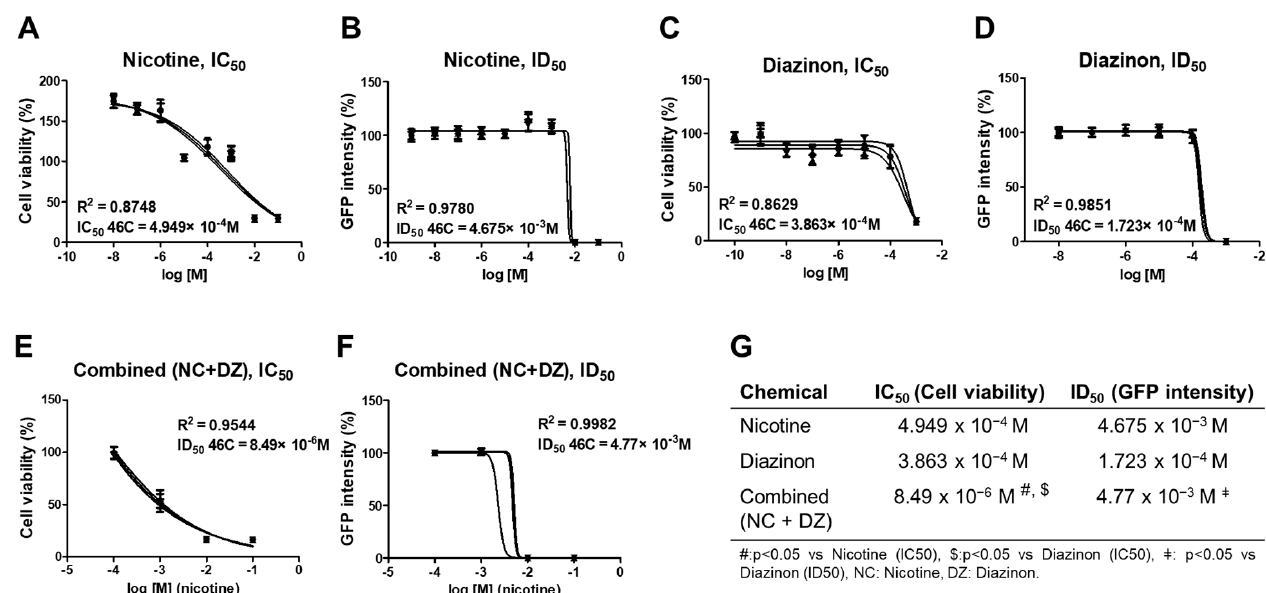
Figure 1. Synergistic adverse effect of combined exposure to nicotine and diazinon in vitro. ( A – F ), Sox1-GFP cell viability assay, IC 50 value was measured with CCK-8 assay and ID 50 value was detected by the intensity of green fluorescent protein (GFP); IC 50 , the half maximal inhibition concentration; ID 50 , the half inhibition concentration for neural differentiation; ( A ), IC 50 value of nicotine; ( B ), ID 50 value of nicotine; ( C ), IC 50 value of diazinon; ( D ), ID 50 value of diazinon; ( E ), IC 50 value of the combined exposure to nicotine and diazinon; ( F ), ID 50 value of the combined exposure to nicotine and diazinon; R 2 , coefficient of determination, the data were presented with standard variation; ( G ), the summery of the values and the statistical significance, # p = 0.0283; $ p = 0.0142, ‡ p = 0.047. Data are presented as the means ± standard deviation of three separate experiments. Statistical significance was determined by two-tailed t -test with the Welch correction test.